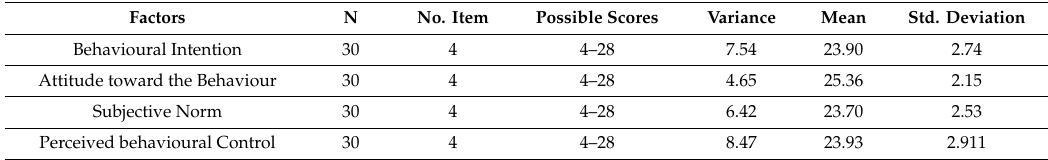
Table 8. Distribution of range, means and standard deviation of intention, attitude, subjective norm, and perceived control as predictors of FoMO-R use ( n =